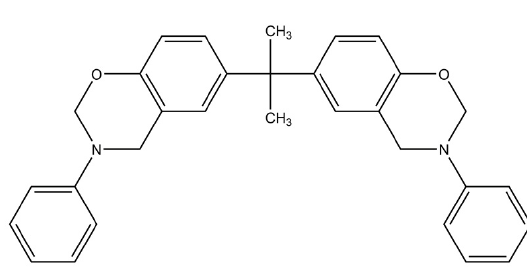
Figure 3. Molecular Structure of difunctional epoxy.